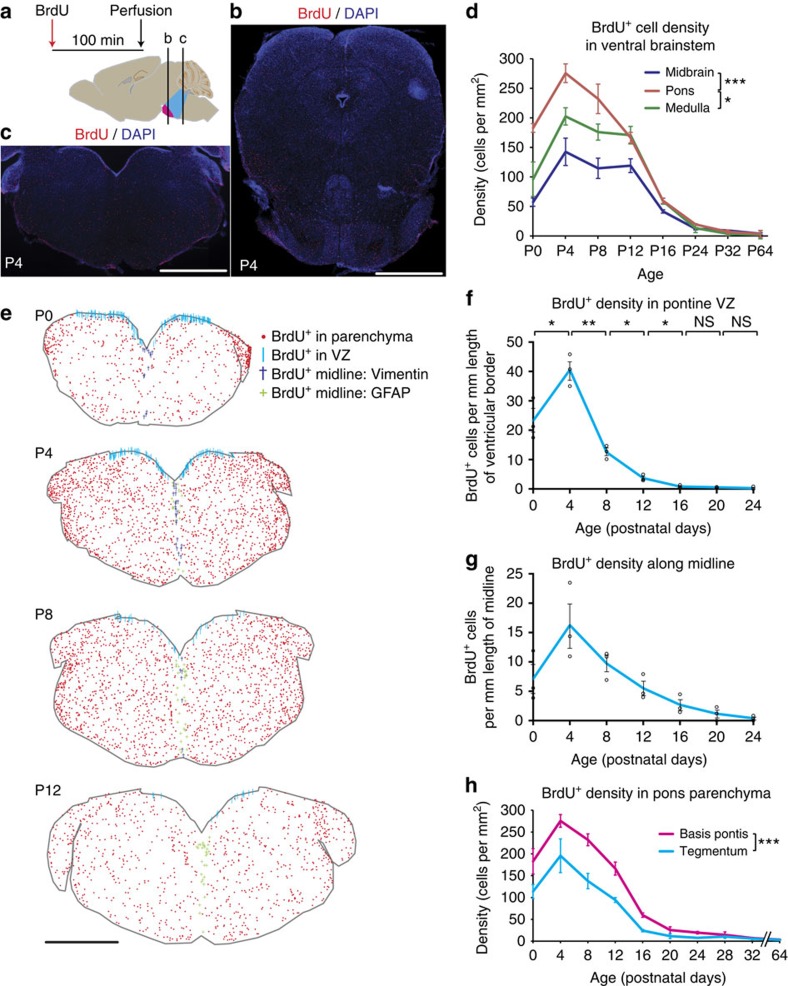
BrdU reveals three compartments of pontine proliferation.(a) CD1 wild-type mice were given a single dose of BrdU by intraperitoneal injection (50 mg kg−1) 100 min before perfusion, thereby labelling acutely proliferative cells. Standard coronal sections indicate levels of basis pontis (b) and pontine 4th VZ (c). (b,c) DAPI and BrdU costains at levels shown in (a) reveal proliferation throughout the mouse brainstem, but concentrated in basis pontis (b) and along 4th ventricle (c). Scale bar, 1 mm. (d) Density of BrdU+ cells is greater in basis pontis (ventral pons) than in ventral midbrain (F1,32=78.16, P<0.0006) or ventral medulla (F1,32=11.53, P=0.0108; regional comparisons by two-way ANOVA and Bonferroni post hoc adjustment; graph shows mean±s.e.m., n=3 mice per timepoint). See Supplementary Fig. 3 for dorsal brainstem regions. (e) Representative sections at level of (c) traced in StereoInvestigator software. Each mark represents one BrdU+ nucleus. Cyan marks represent BrdU+ cells in VZ, which was defined by the density of DAPI along the 4th ventricle; midline populations were defined by contact with vimentin (dark blue) or GFAP (green) fibres that contacted the midline glial structure; all other BrdU+ nuclei were considered parenchymal and labelled red. Scale bar, 1 mm. (f) Density of proliferative cells along pontine VZ; graph shows individual replicates with mean±s.e.m. (n=3 mice per timepoint); comparisons are by unpaired t-test. (g) Density of BrdU+ cells along midline; graph shows individual replicate values with mean±s.e.m. (n=3 mice per timepoint). (h) Density of BrdU+ cells is greater in basis pontis than pontine tegmentum (F1,40=39.06, P<0.0006; regional comparisons by two-way ANOVA and Bonferroni post hoc adjustment; graph shows mean±s.e.m., n=3 mice per timepoint). *P<0.05; **P<0.01, ***P<0.001. NS, not significant.